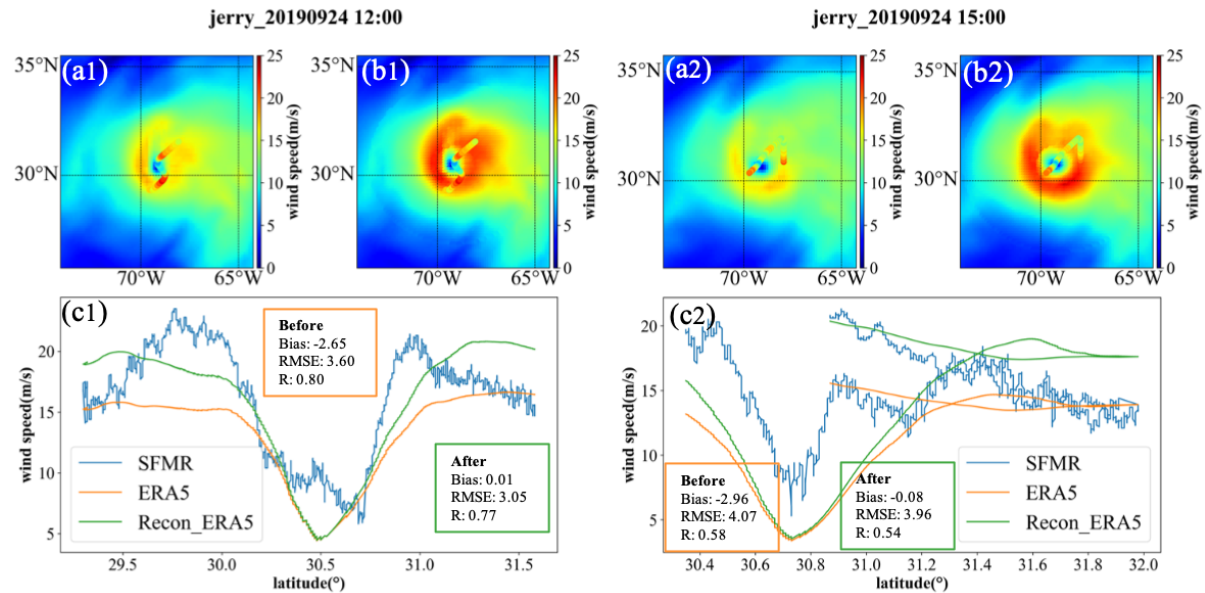
Figure 8. Comparison of wind field ( a1 – b2 ) and profile ( c1 , c2 ) before and after tropical cyclone reconstruction at Jerry in